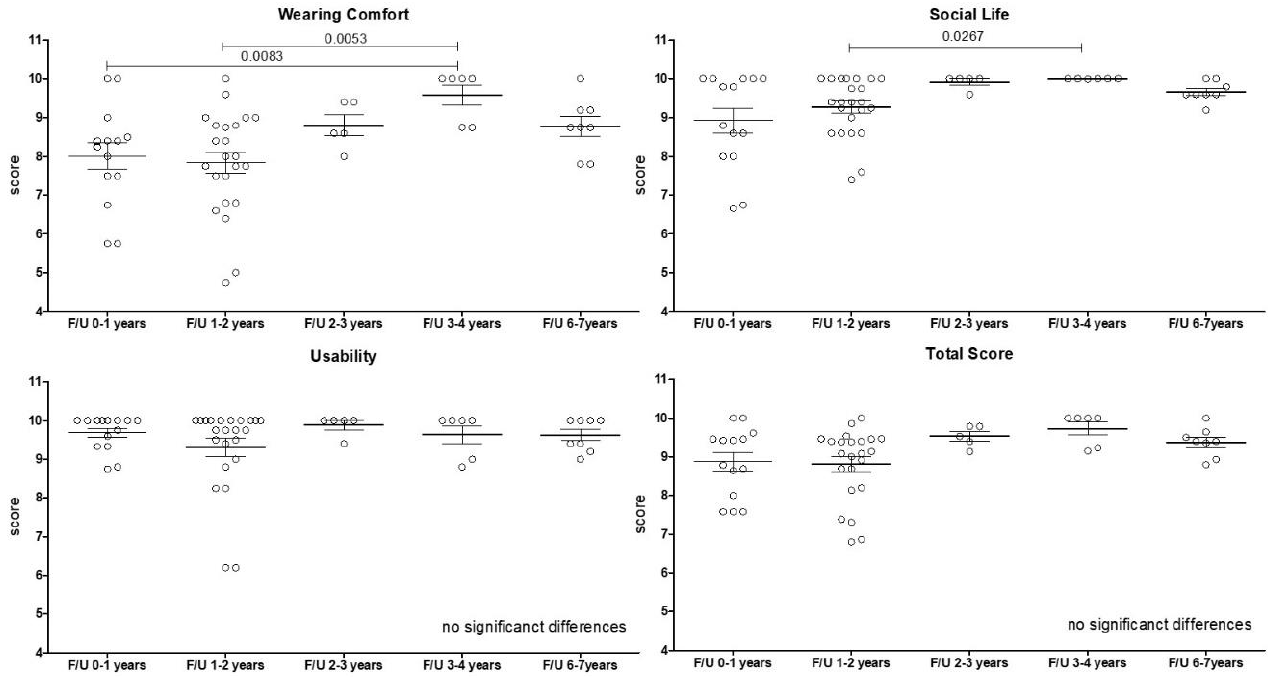
Figure 3. Audio Processor Satisfaction Questionnaire (APSQ) as a function of device used. Box- plot shows the distribution of outcomes from the Audio Processor Satisfaction Questionnaire (APSQ) separated for the type of device used (SU (Single Unit) vs. BTE (Behind the Ear)) and split for the dimensions of “Wearing Comfort”, “Social Life”, “Usability” and the resulting “Total Score”. APSQ outcomes for each dimension (wearing comfort, social life, usability and total score) are displayed in boxplots, with the ends of the box representing the upper and lower quartiles (interquartile range), the vertical line inside the box marks the median and the whiskers extend from the highest to the lowest observationan the individual outcomes are displayed as circles within the boxplot (Table 3, Figure 4).